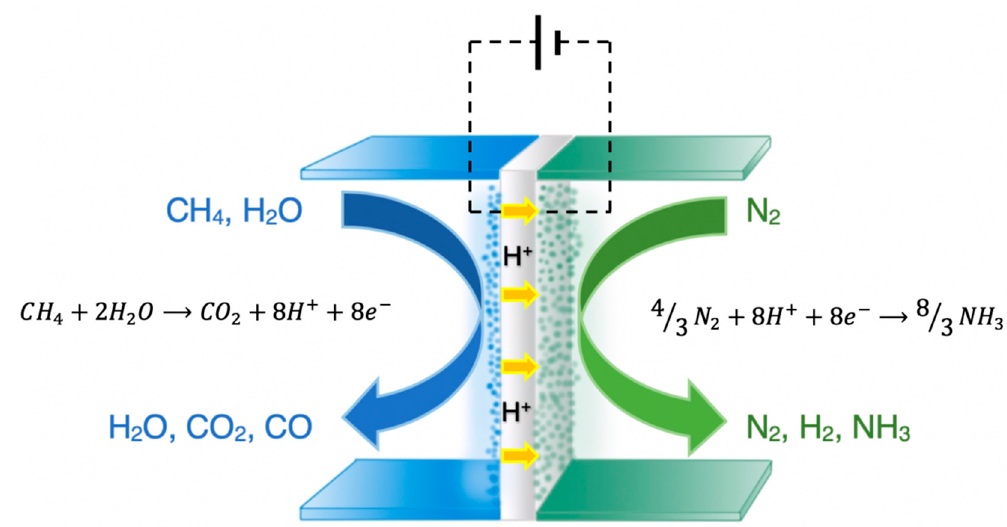
Figure 3. Schematic diagram of the electrochemical membrane reactor used for NH 3 synthesis from CH 4 , H 2 O, and N 2 .